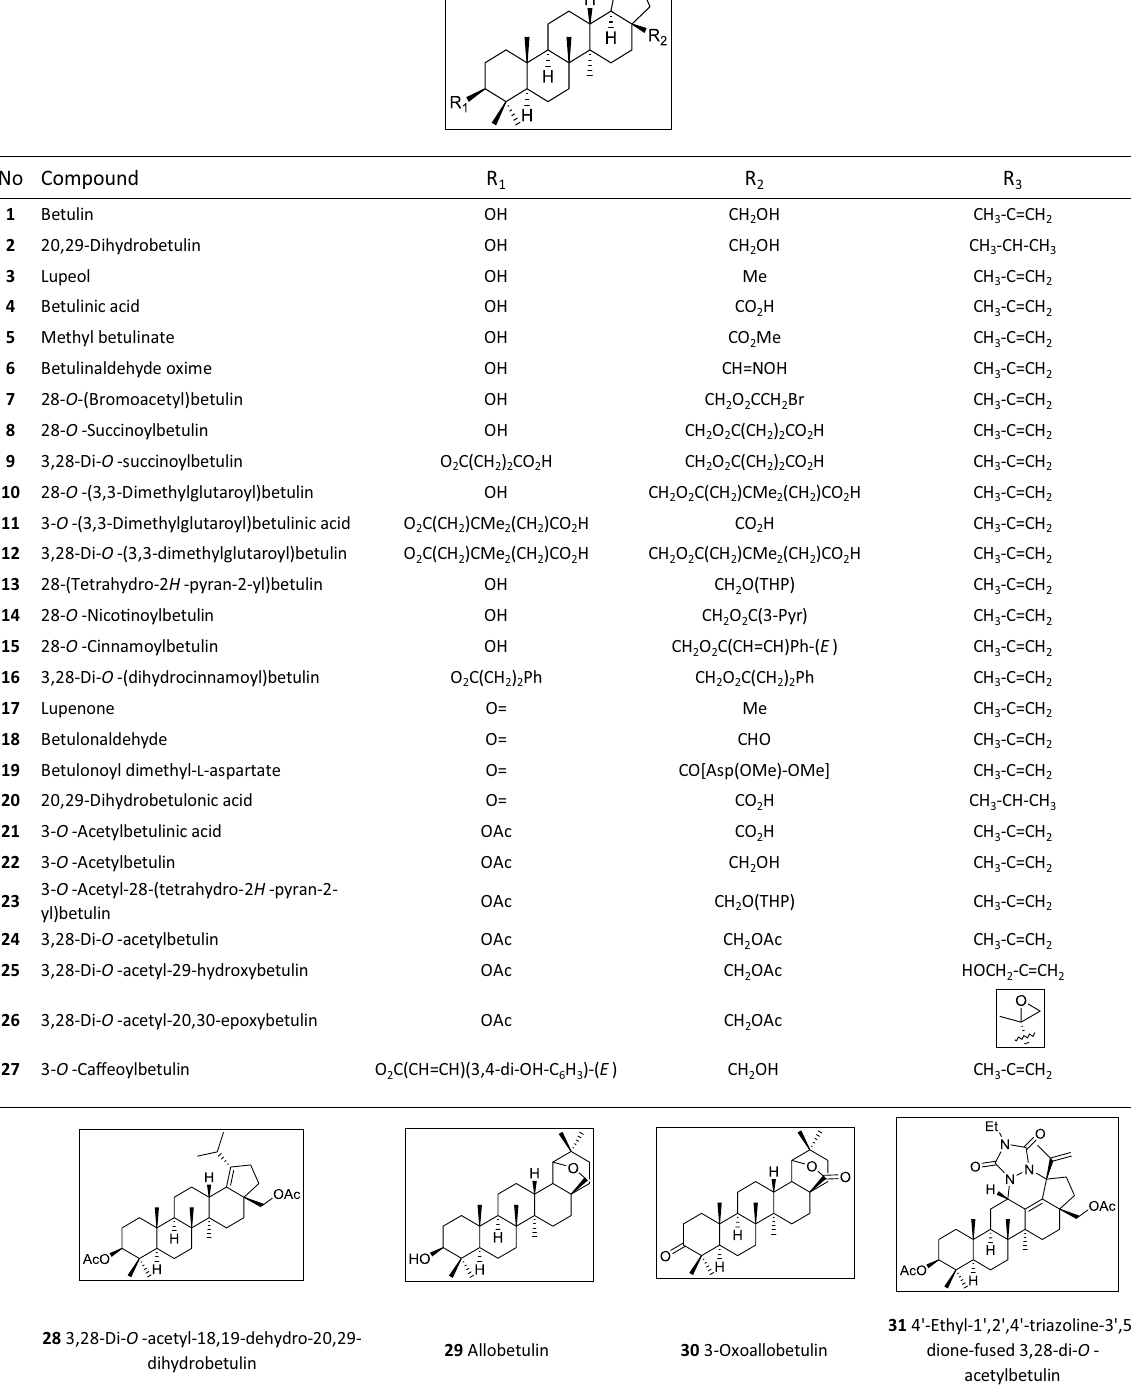
Table 1. Structures of the betulin derivatives that were used for [ 3 H]TC transport inhibition and [ 3 H]preS1 binding inhibition experiments. These compounds derived from a TargoSet (Adipogen AG) or were synthesized as outlined elsewhere 52–54 . Ac, acetyl; Asp, aspartate; Et, ethyl; Me, methyl; Ph, phenyl; Pyr, pyridinyl; THP, 2 H